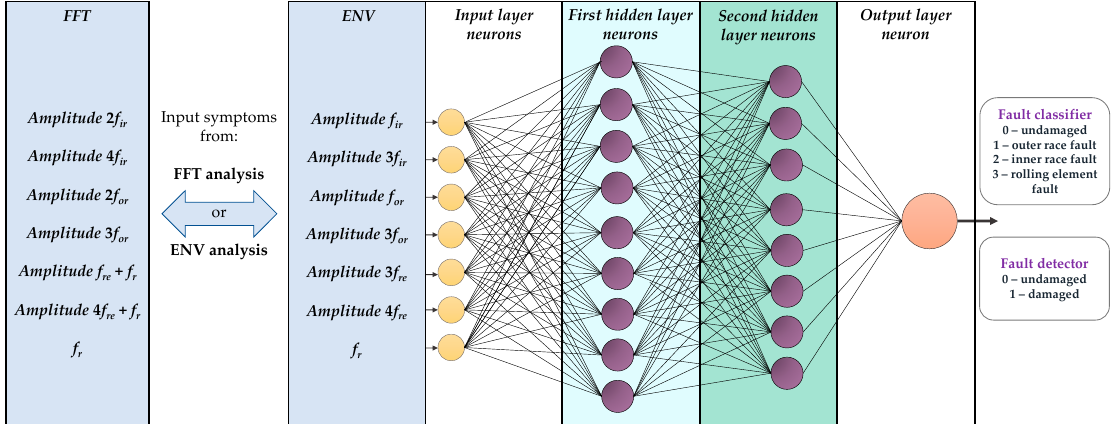
Figure 8. Schematic diagram of a fault detector or fault classifier based on MLP network with different input signals: after FFT or ENV analysis.